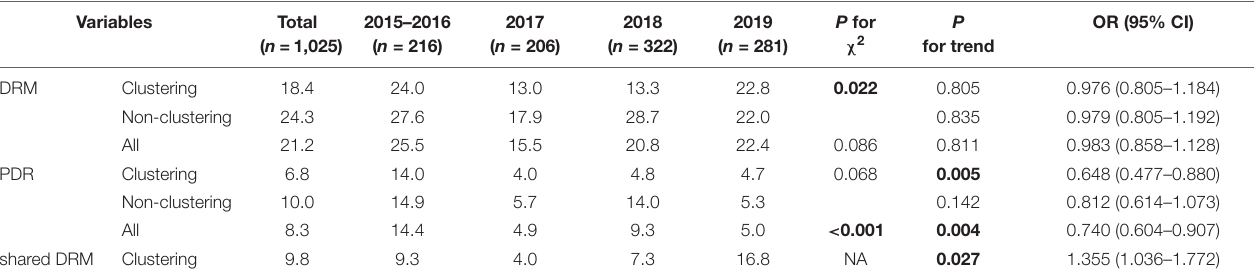
FIGURE 5 | Sankey plots. (A) Lineage dispersal relation between subtype, clustering, and age among all individuals. (B) Lineage dispersal relation between subtype, DRMs class, and PDR among all individuals. (C) Lineage dispersal relation between subtype, PDR, and DRM shared among clustering individuals within networks. DRM, drug resistance mutation; PDR, pretreatment drug resistance; NA, not available. TABLE 2 | Prevalence of DRM, pretreatment drug resistance (PDR), and shared DRM among clustering and non-clustering individuals from 2015 to 2019